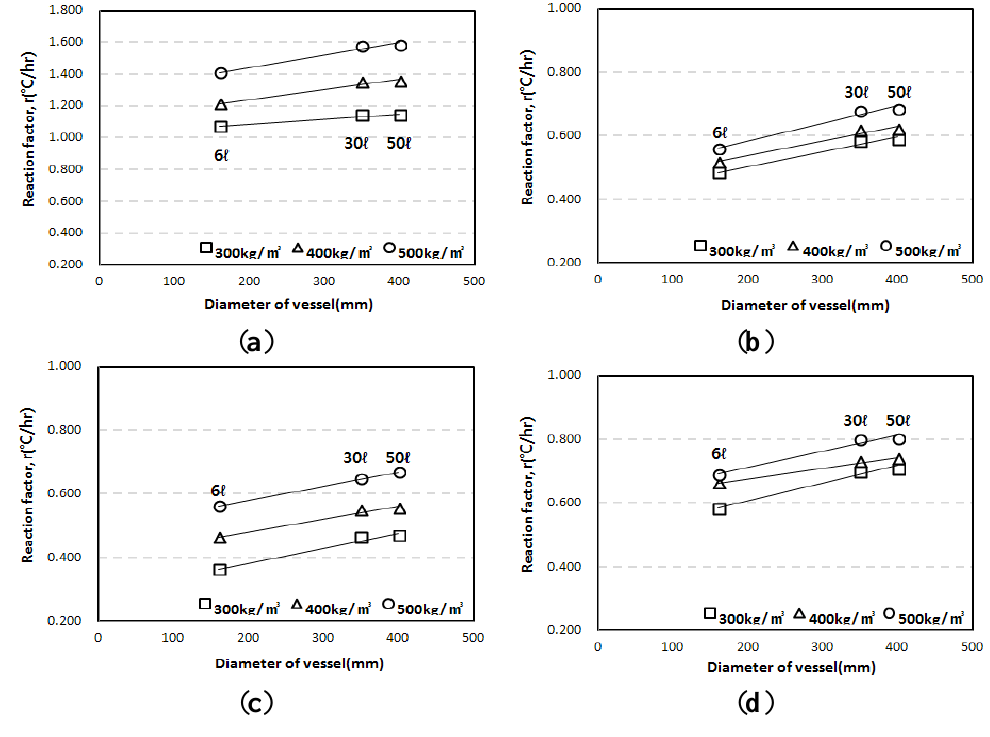
Figure 9. Reaction factor obtained from the 6 L, 30 L, and 50 L specimen tests. ( a )